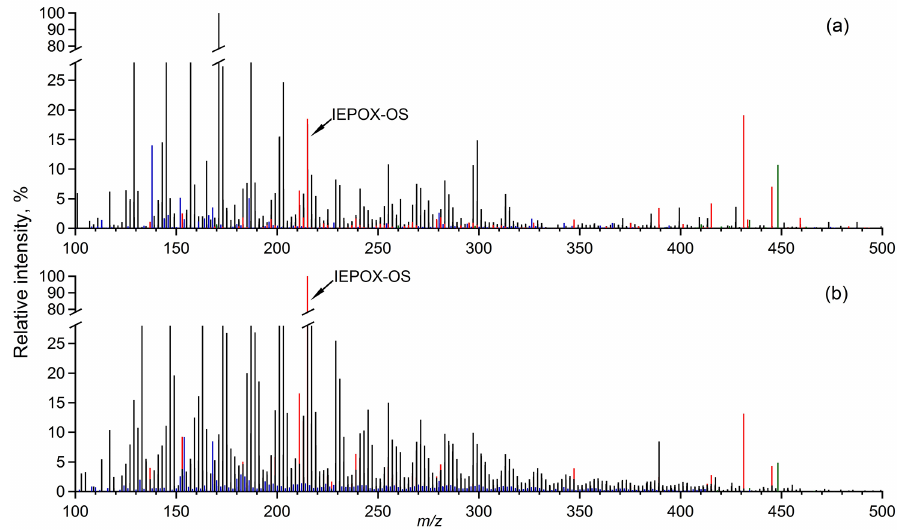
Figure 1. (-)-nanoESI-UHRMS of the representative PM2.5 samples during (a) IOP1 and (b) IOP2. The line colours in the mass spectra correspond to the CHO (black), blue (CHON), CHOS (red) and CHONS (green) formulae assignments. The relative-intensity axis was split to make a large number of ions with low intensities visible.